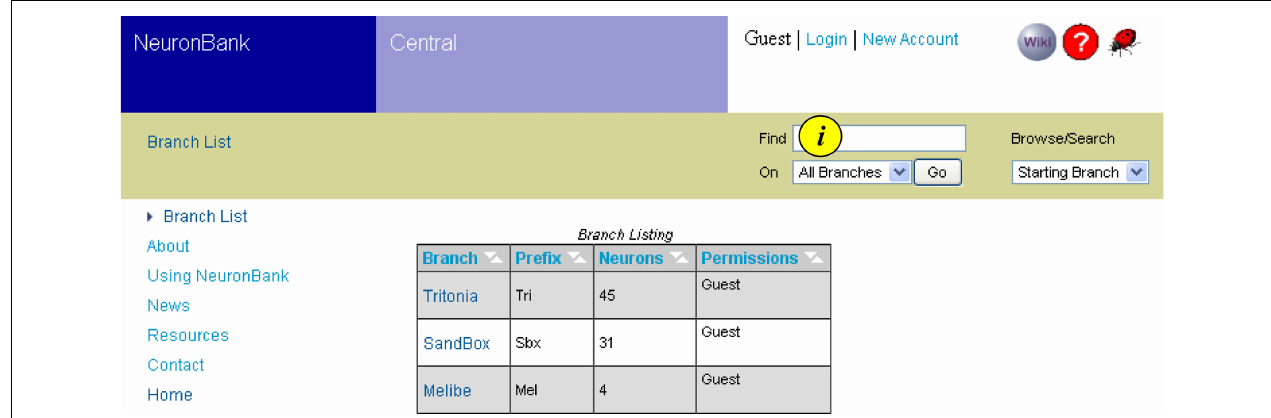
FIGURE 4 | Branch List. Screen shot showing the Branch List and the navigation bar at the top. The branch list is dynamically generated to show the active branches, the number of neurons in each branch and the permissions of the user for each branch. Text searches can be initiated from the navigation bar ( i